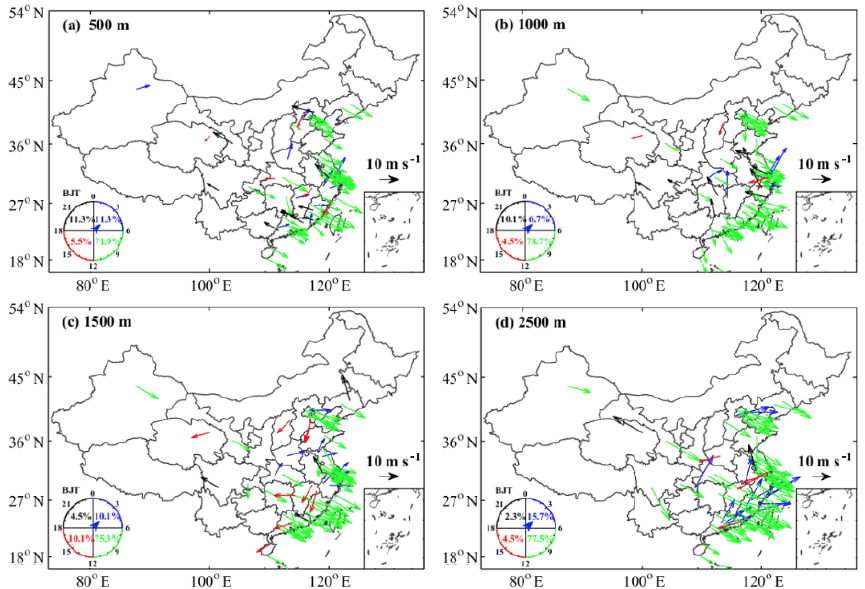
Figure 9. Diurnal phase and amplitude of mean maximum wind speed over the period from November 2018 to March 2019 at (a) 500m, (b) 1000m, (c) 1500m and (d) 2500m above ground level (a.g.l.). The direction in which an arrow points denotes the China standard time (CST) when the maximum occurs (shown on the clock dial in the bottom left corner of each panel) and the arrow length represents magnitudes of mean maximum wind speed. The arrow colour denotes varying diurnal phases: blue (00:00–06:00CST), green (06:00–12:00CST), red (12:00–18:00CST) and black (18:00–24:00CST).